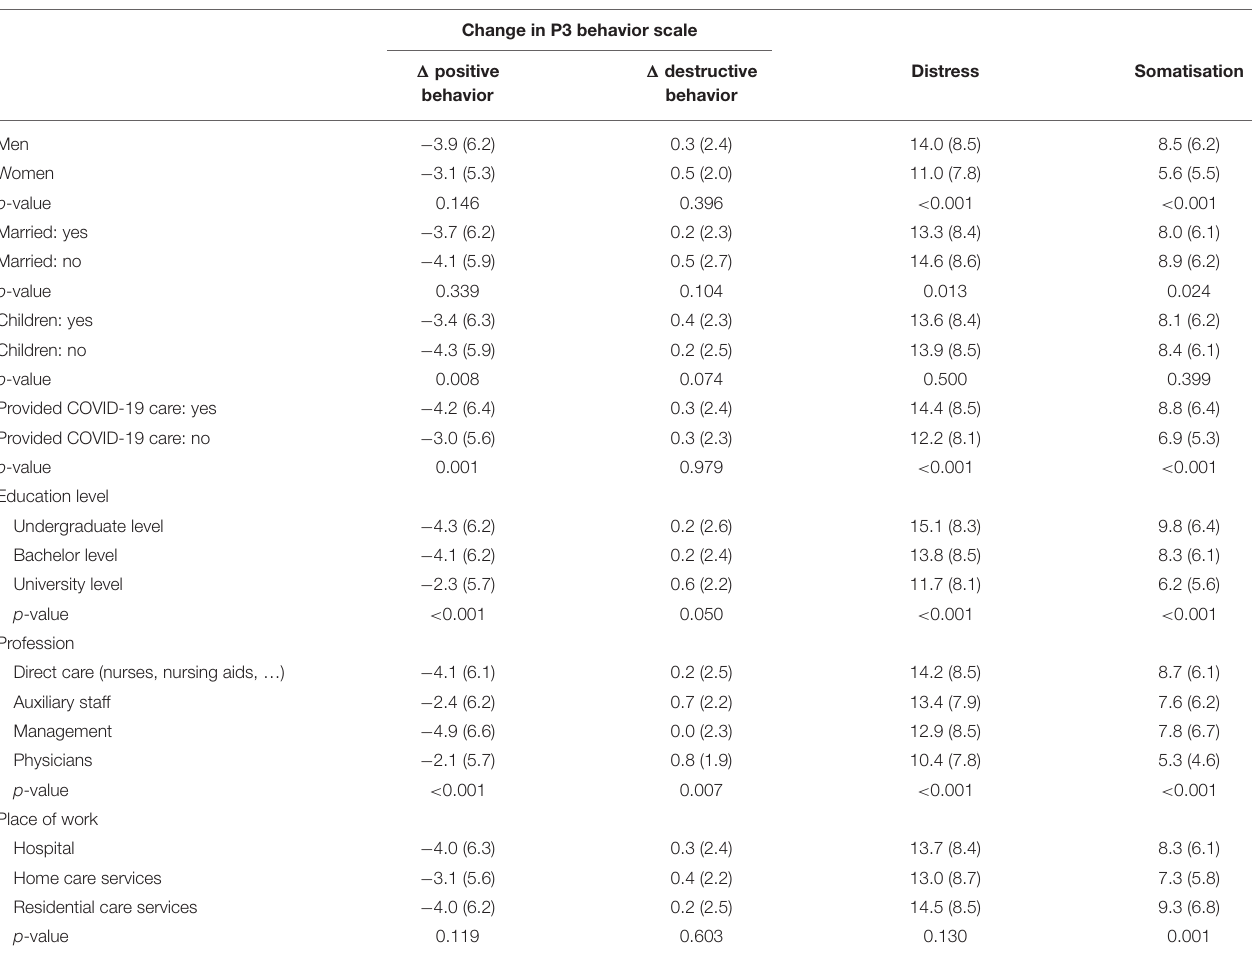
TABLE 3 | Comparing P3 behavior scale, distress scale, and somatization scale scores between sample